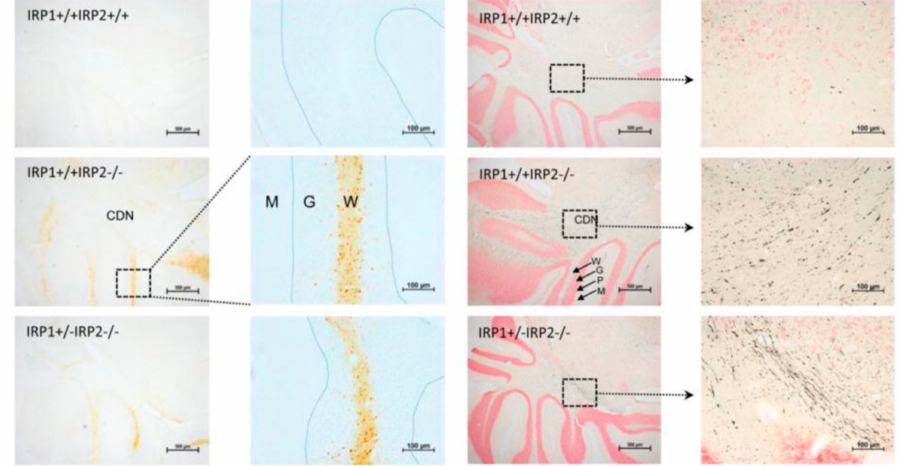
Figure 1. Perls’ DAB stain ( left ) and amino cupric silver stain ( right ) of WT ( top ), Irp2 − / − ( middle ), and Irp1 +/ − Irp2 − / − ( bottom ) mouse cerebellum sections showing a dose-dependent effect of IRP ablation on iron accumulation in white matter (yellow) and axon degeneration (black strands). Abbreviations: CDN—cerebellar deep nuclei, W—white matter, G—granular cell layer, P—Purkinje cell layer, M—molecular layer. Modified with permission from ref. [1] 2015